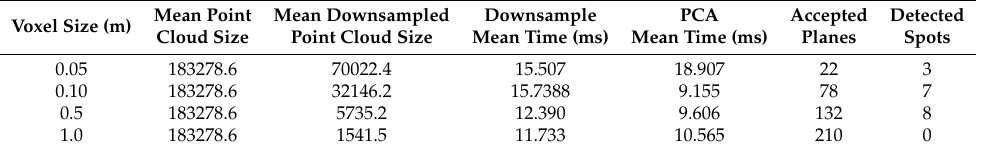
Table 5. Results for several values of voxel size.